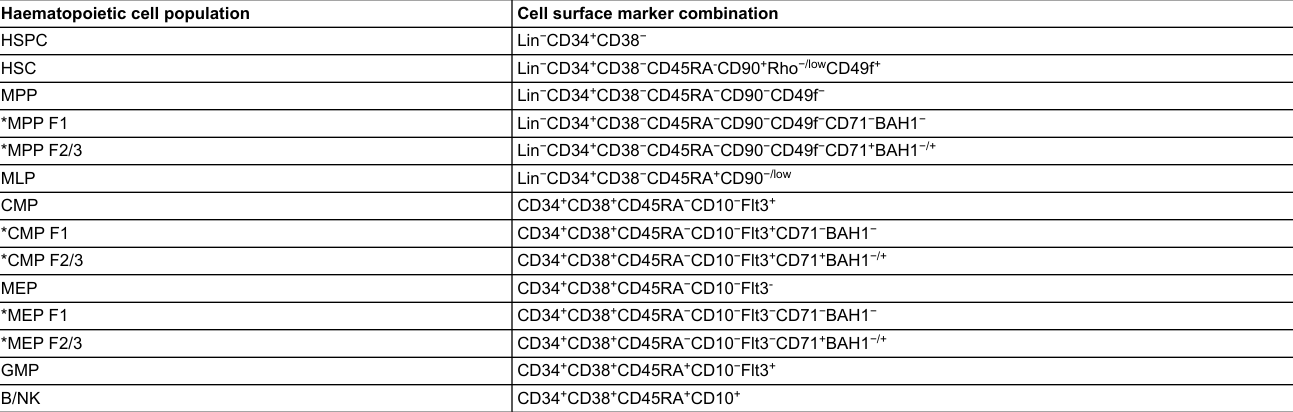
Table 1: Human haematopoietic stem and progenitor cell phenotypes. Haematopoietic cell population Cell surface marker combination